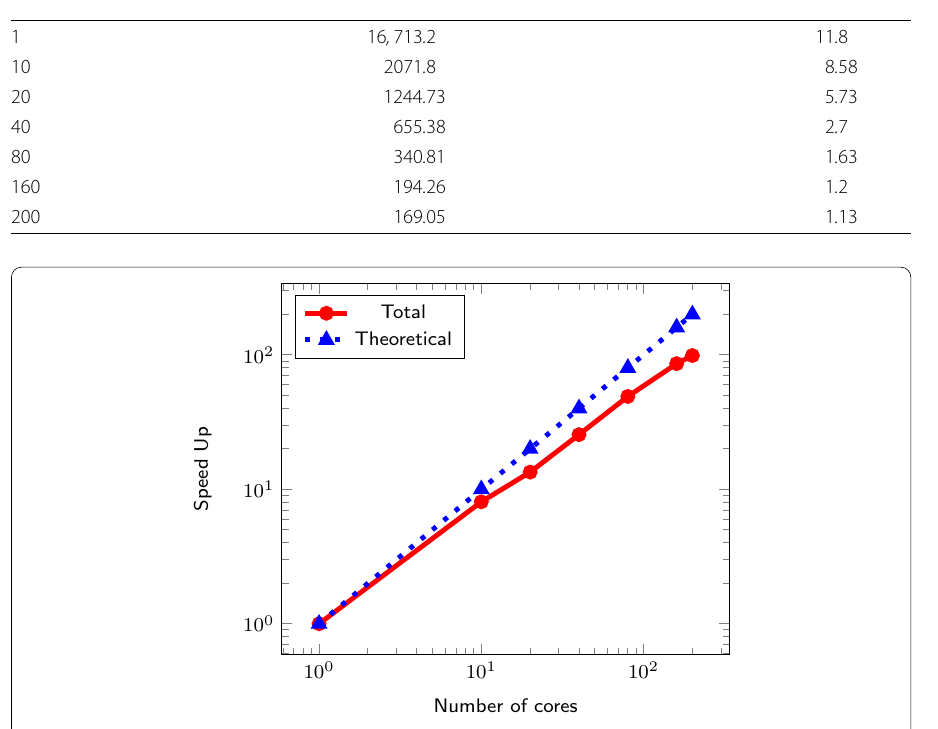
Fig. 12 Speed Up of the Golub-Kahan bidiagonalization algorithm for a prestressed concrete block of sizes m = 1538103 and n = 750000. The (1,1) block is solved using MUMPS